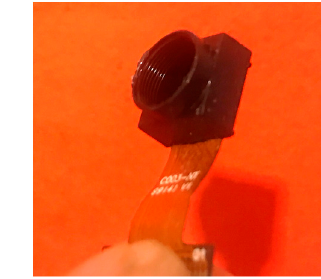
Figure 6. Lens seat with a ribbon connector. The image sensor can be seen from the left panel.